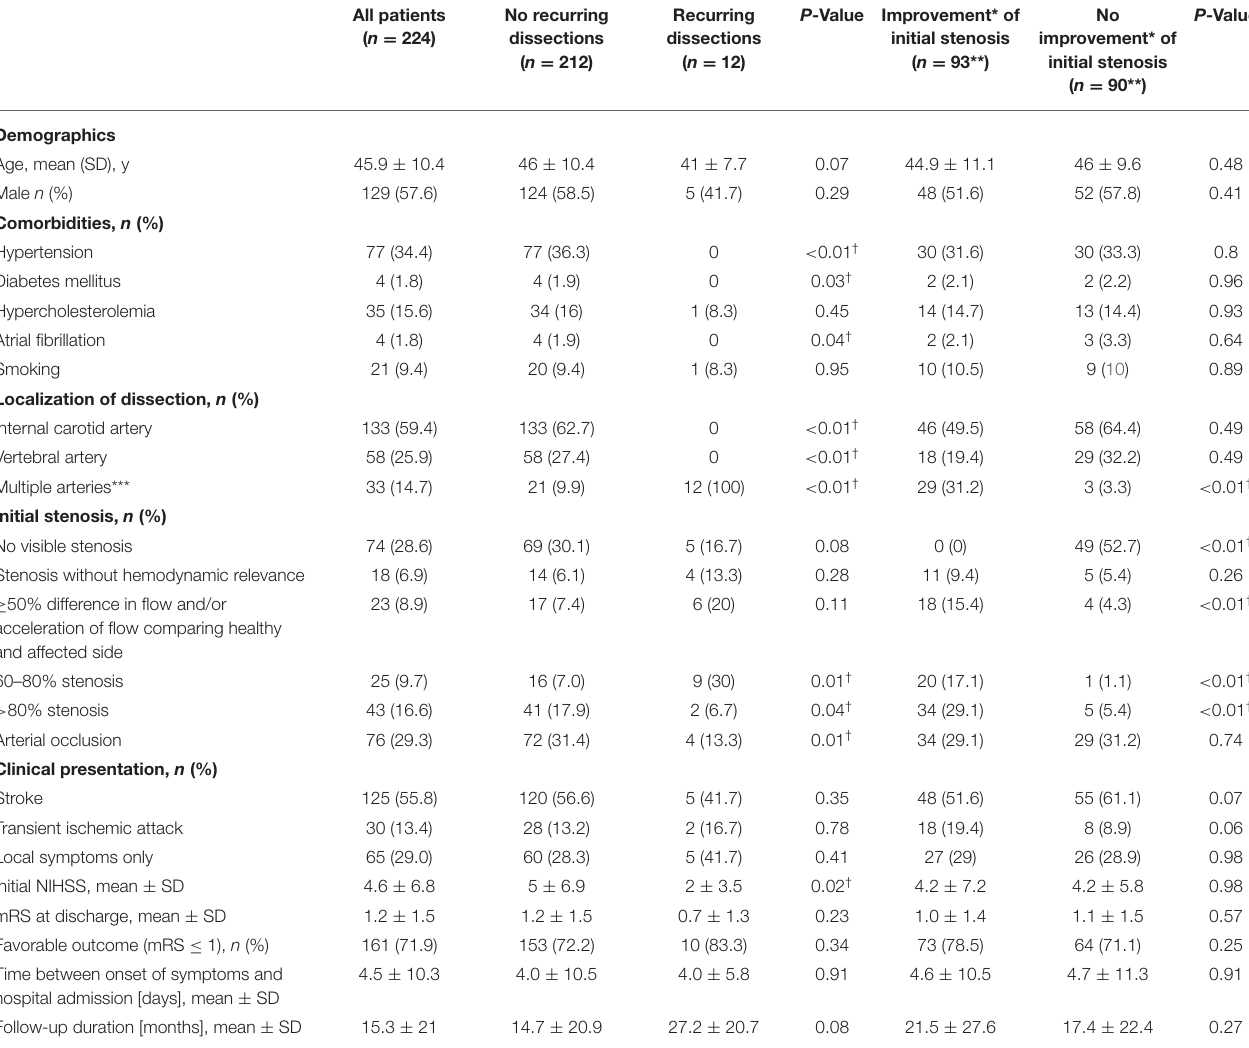
TABLE 1 | (Para-) clinical characteristics of study population and duration of follow-up.